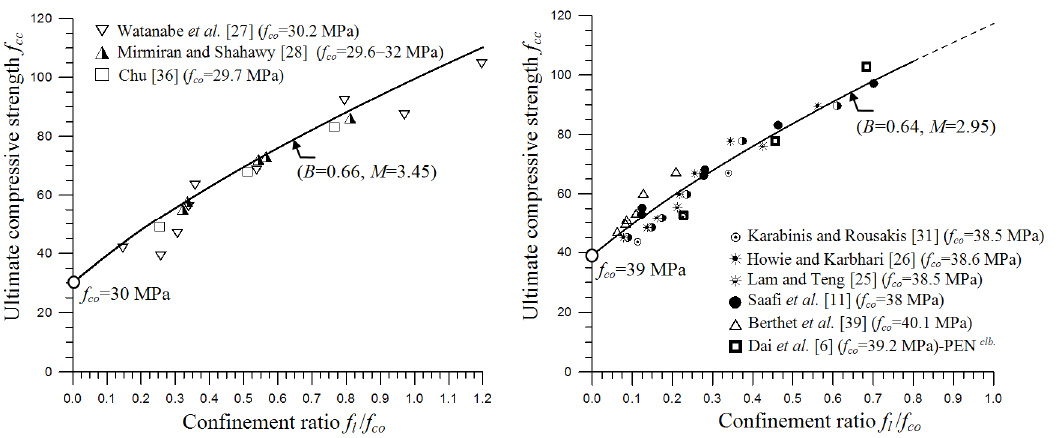
= 52 and 81.4 MPa) FRP co